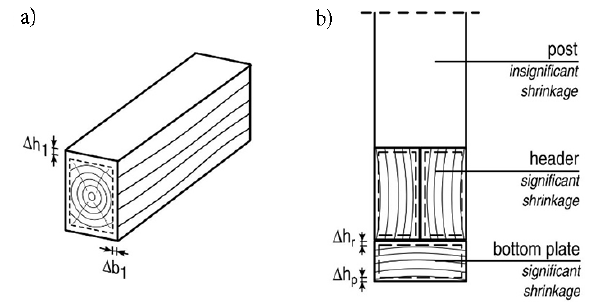
Figure 4. Shrinkage in wood: a – in single element; b – in joint connecting different